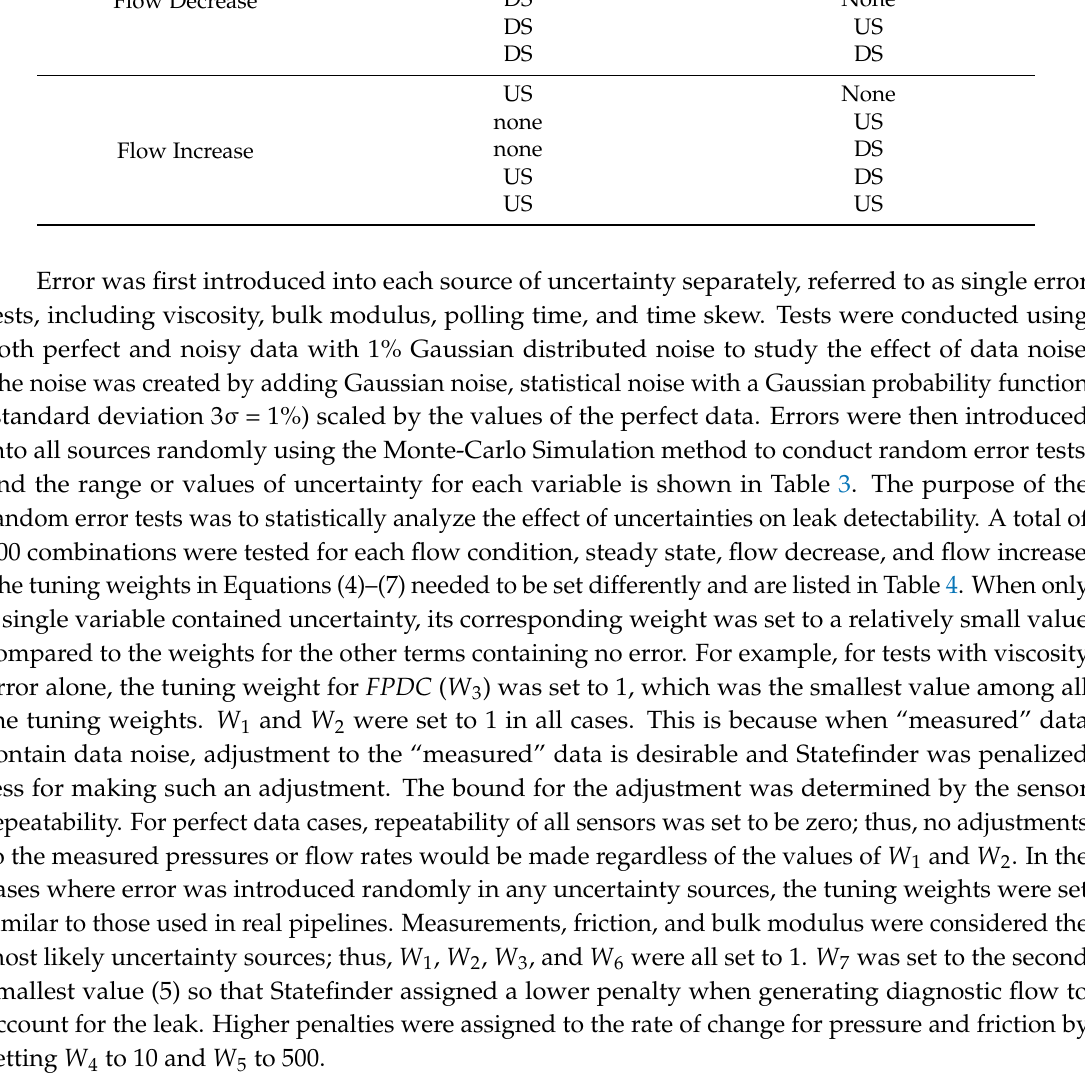
Table 3. The range of uncertainty for each variable in random error